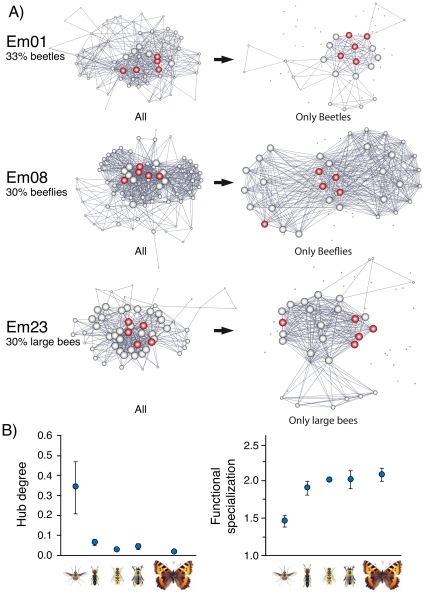
Pollinator effects on network topology.a) Expected changes in network connectivity due to different functional groups of pollinators. Network graphs are depicted for three example populations, illustrating the relationships among individual plants when all pollinator species are included (left) and when only specific subsets are considered (right). Note how the “hub” plants spread all over the partial networks. b) Differences among pollinator type (from left to right, beeflies, beetles, hoverflies, bees and butterflies) in hub degree (F4,16 = 21.83, P = 0.0001) and functional specialization (F4,16 = 4.13, P = 0.036).